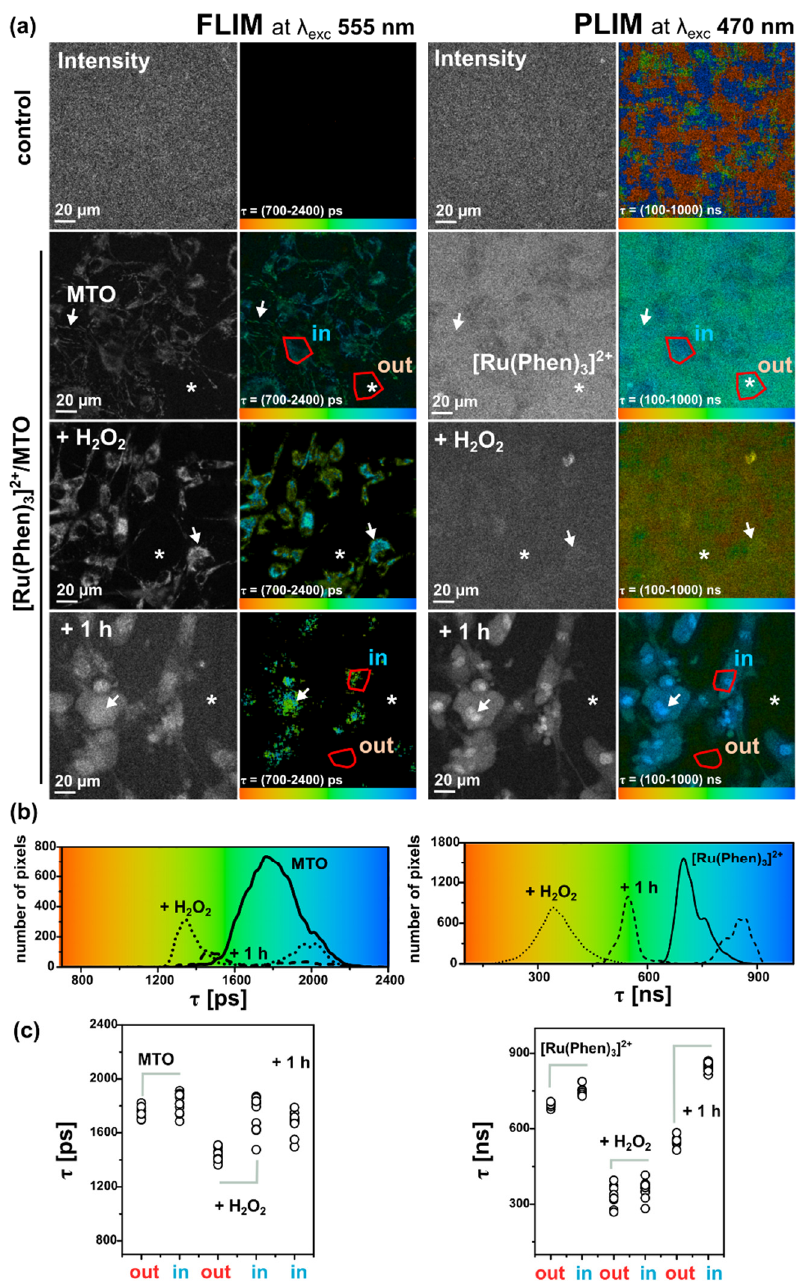
represent the luminescence intensity of MTO and [Ru(Phen) 3 ] 2+ . The samples were excited with laser light at 555 nm (MTO) and 470 nm ([Ru(Phen) 3 ] 2+ ). ( d ) MTO and [Ru(Phen) 3 ] 2+ luminescence lifetime values detected at the conditions mentioned in ( b ). At least ten representative ROI was selected.